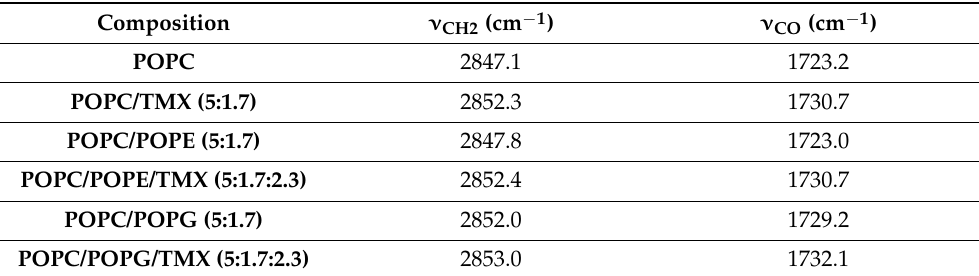
Table 3. The effect of TMX on the maximum frequency of the ν CH2 symmetric stretching and ν C=O stretching bands for various phospholipids and phospholipid mixtures. The molar ratios are given between brackets.